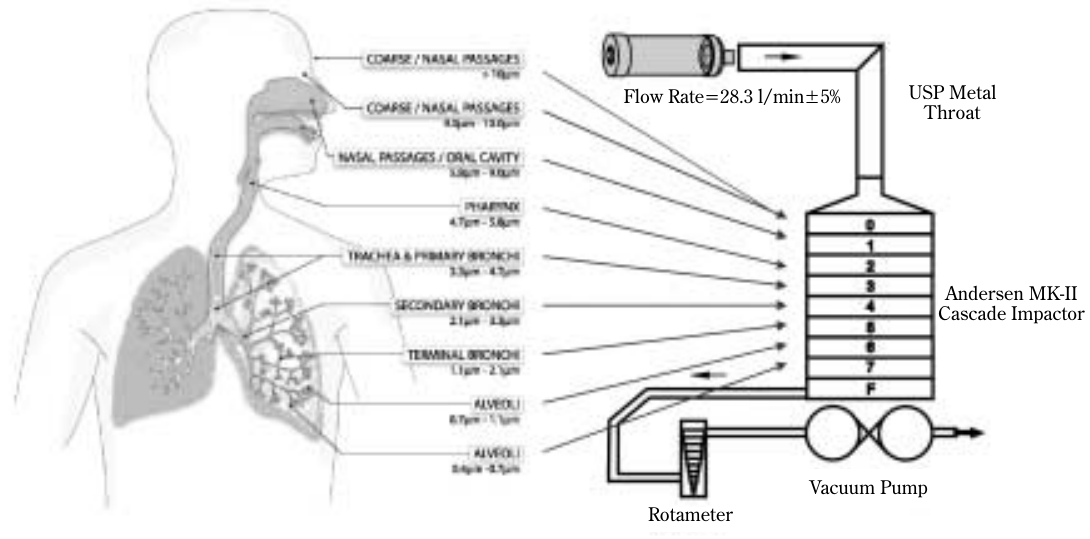
Fig. 5 Relationship between Andersen 8-stage CI cut sizes at 28.3 L/min and likely particle deposition in the